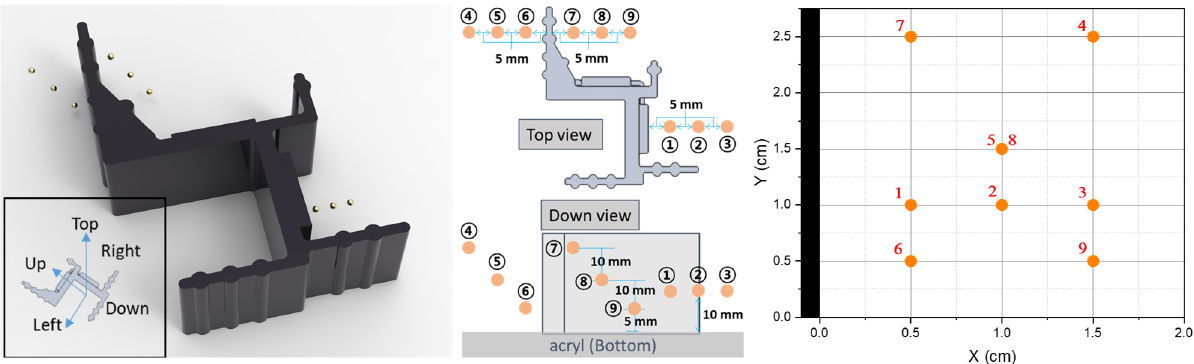
Figure 6. Heating module and temperature measurement points around the heater.